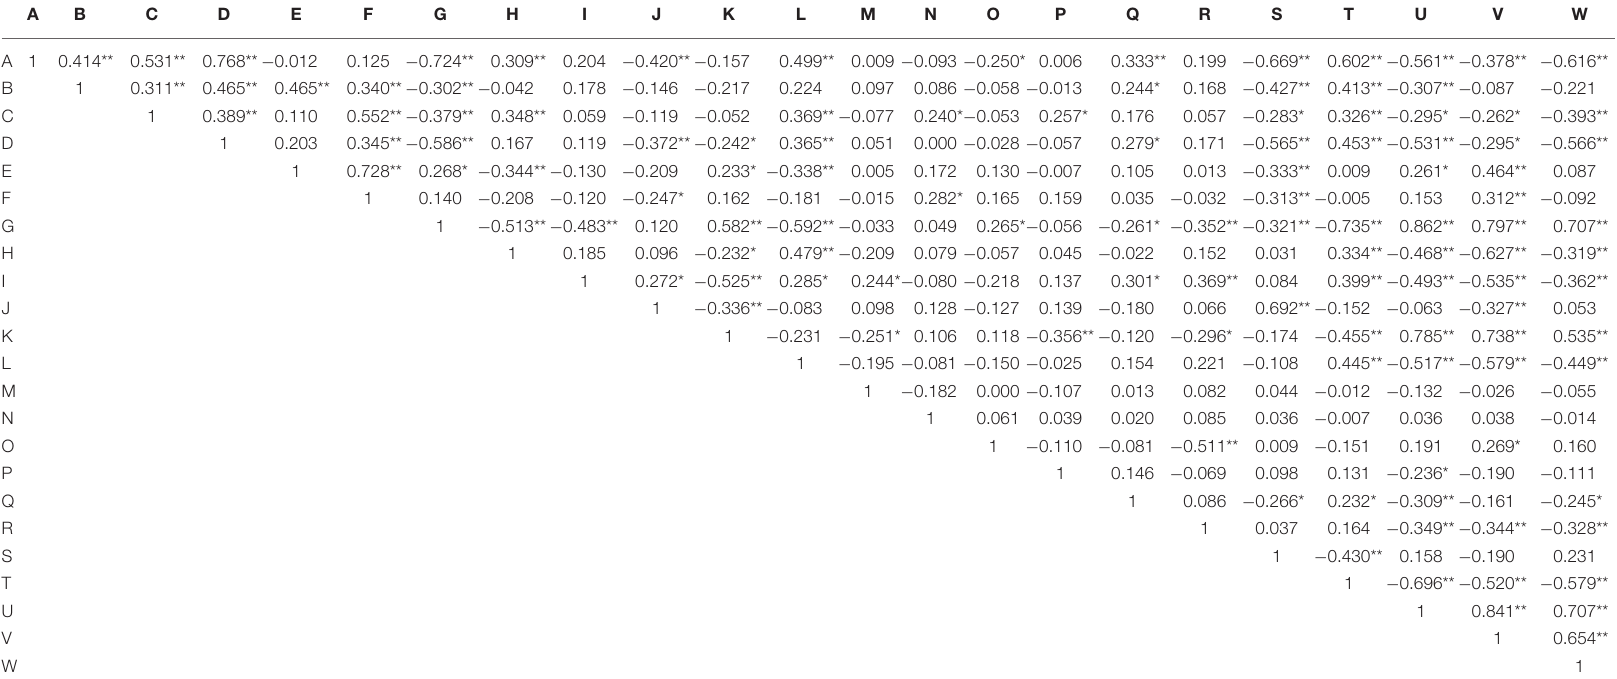
TABLE 4 | Pearson correlations (two-tailed test, N = 72) between various